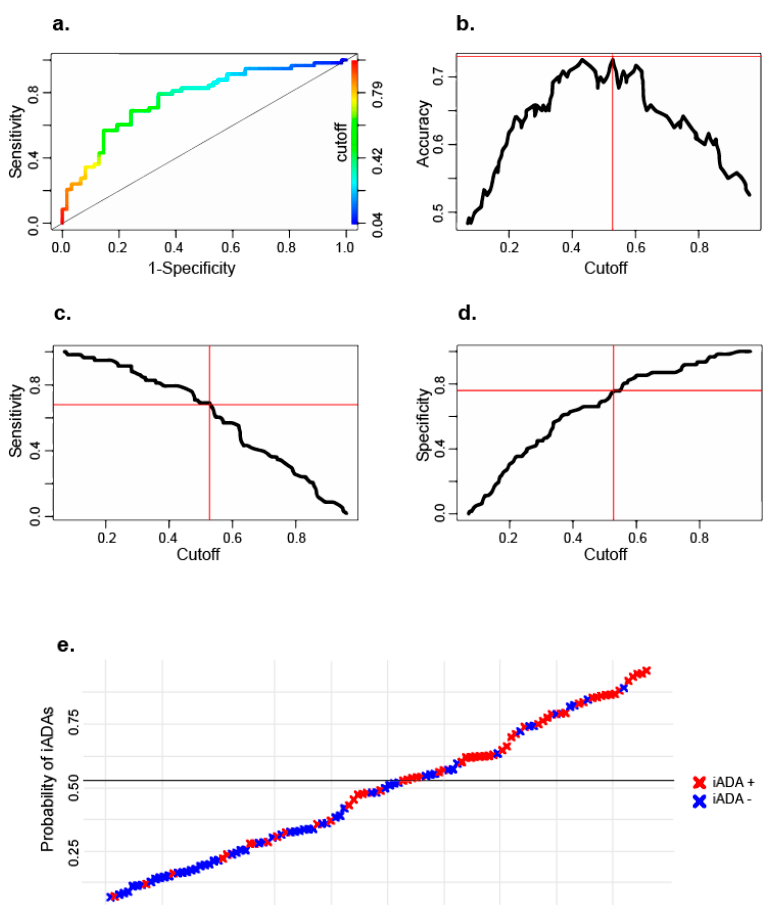
Figure 2. Results from the LR model. ( a ) ROC curve, AUC = 0.77. Colors represent the different possible cutoff* values; ( b ) Accuracy of the model at different cutoffs* (maximum of 0.73 at cutoff 0.53); ( c ) Sensitivity of the model. At the chosen cutoff sensitivity is 0.69; ( d ) Specificity of the model at the chosen cutoff is 0.76; ( e ) Visualization of the predicted (Y axis) versus observed outcome (color coded) per patient. The line drawn shows the chosen cutoff. * The cutoff is a chosen decision threshold above which patients are predicted as positive (will develop ADAs). Lower cutoffs favor sensitivity, higher cutoffs favor specificity.